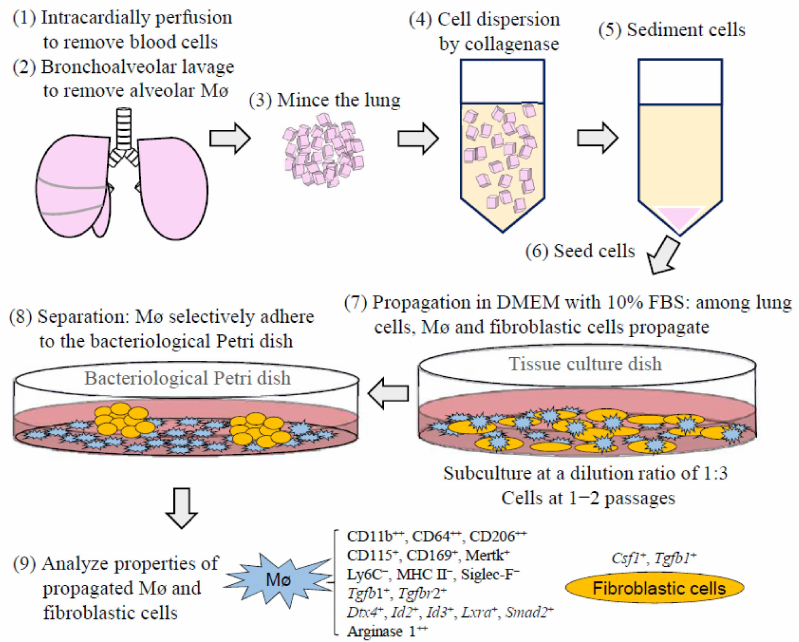
Figure 9. Schematic drawing illustrating the procedures of lung tissue-resident Mø propagation by co-culture with lung fibroblastic cells and separation of lung Mø from fibroblastic cells as well as the expression characteristics of these